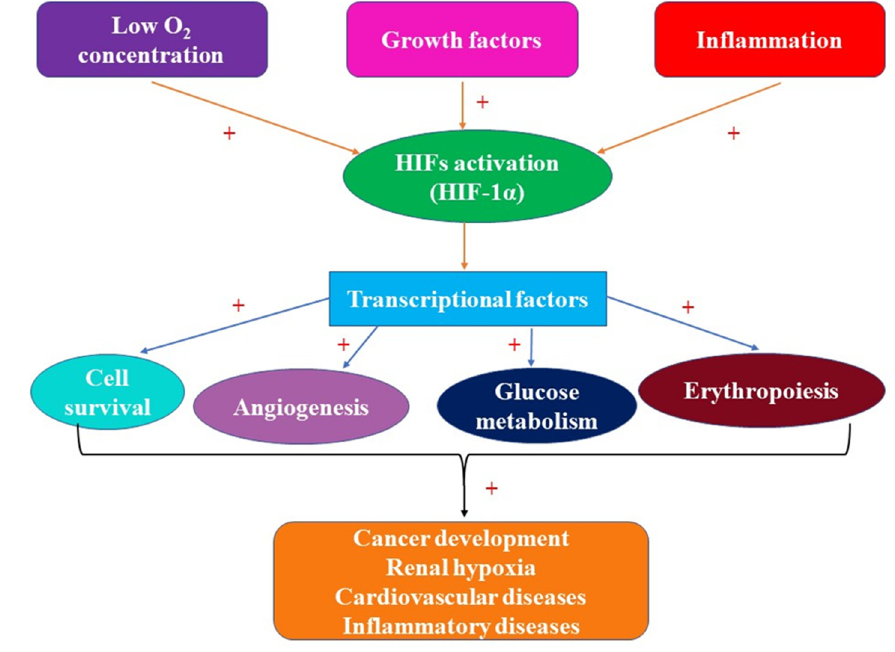
Figure 1. HIFs activation and involvement in pathological processes.